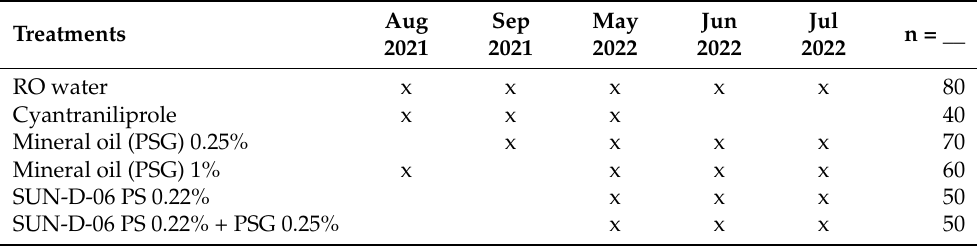
Table 1. Treatments evaluated for efficacy against western flower thrips (WFT) in ingestion assays con- ducted during 2021–2022. ‘x’ indicates the specific treatment was evaluated in the assay conducted during the month/year the column represents. ‘n’ indicates the total number of replicates for each treatment. Aug Sep May Jun Jul Treatments n = __ 2021 2021 2022 2022 2022 RO water x x x x x 80 Cyantraniliprole x x x 40 Mineral oil (PSG) 0.25% x x x x 70 Mineral oil (PSG) 1% x x x x 60 SUN-D-06 PS 0.22% x x x 50 SUN-D-06 PS 0.22% + PSG 0.25% x x x 50 For ingestion assays, leaf discs were allowed to air dry in darkness in the spray hood after spraying before introducing WFT. Ten adult WFT per assay container were siphoned onto each leaf disc, after which the vented lids were